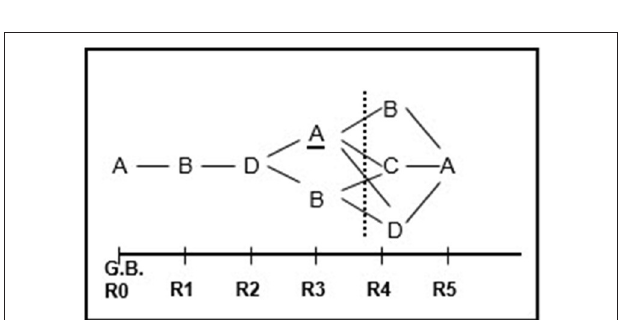
FIGURE 2 | Behavioral pattern extracted after assigning significant conditional behaviors (behaviors with a conditional probability greater than the unconditional probability) to each lag. The behavior pattern extracted from the presented illustration exhibits a regularity consisting of expressions of sorrow or sadness being followed by expressions of self-perceived improvement and these expressions, in turn, being followed by joy at having overcome the problem. From there, the pattern bifurcates, leading either to the initial situation of sorrow and sadness or to expressions of self-perceived worsening.